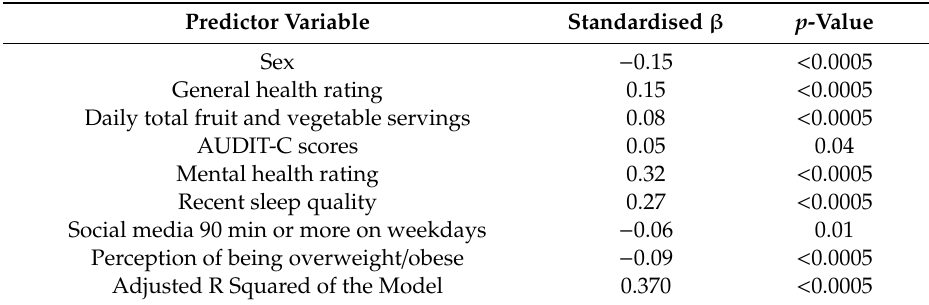
Table 7. Multiple Linear Regression Model with EVI Scores as the Dependent